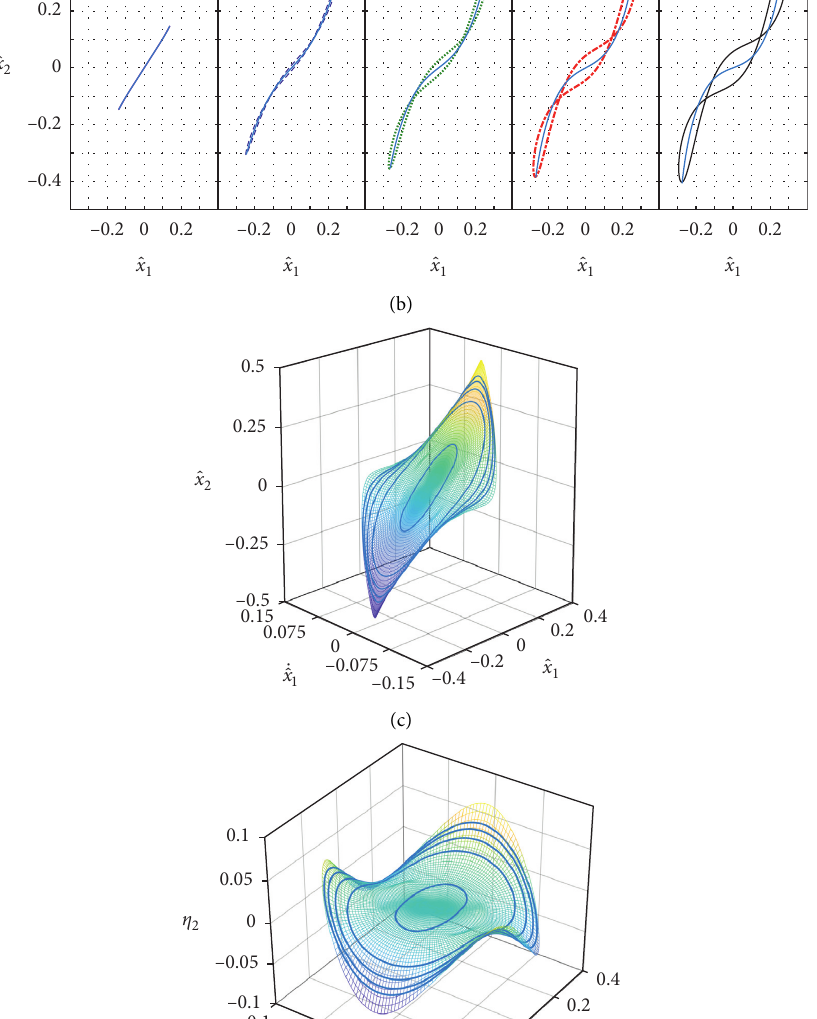
� 1 . 15, and the corresponding free periodic h 1 � 36, with 35 equally sized elements a